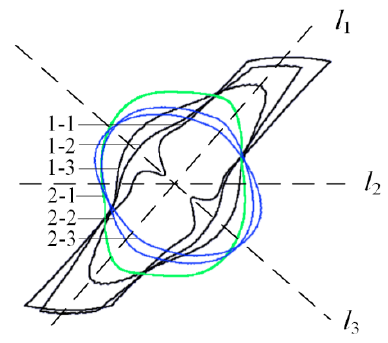
Figure 16. Ablation area boundaries of different tomographic images of the 1st and 2nd plies of A60. The angle of l 1 , l 2 , and l 3 are 45°, 0°, and −45°.